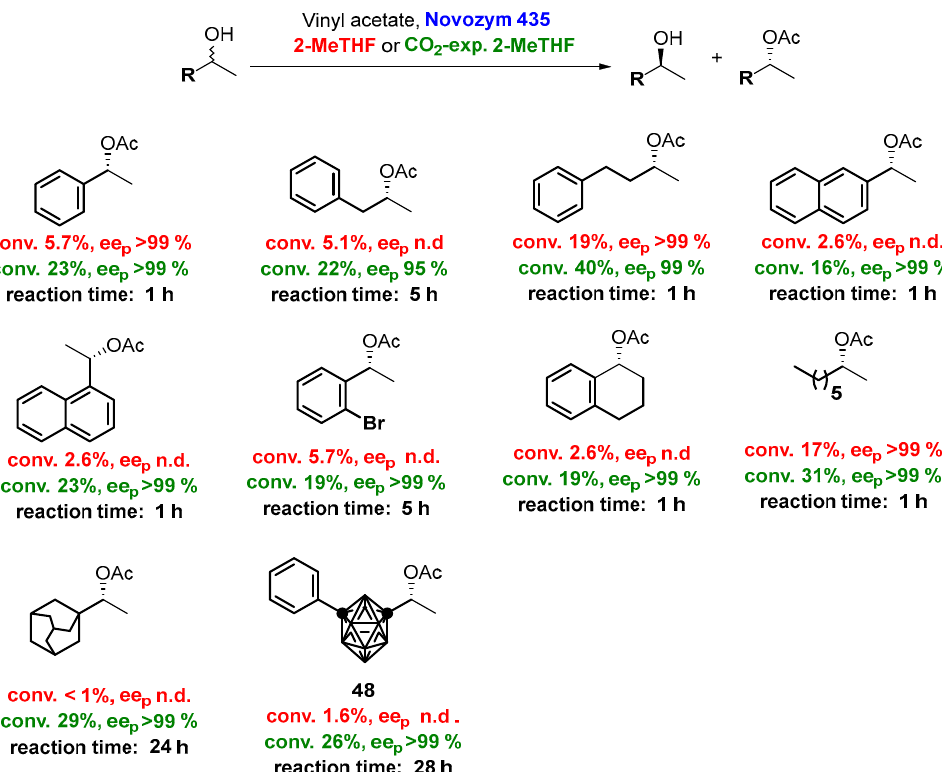
Figure 25. Lipase-catalyzed resolution of bulky alcohols using CO 2 -expanded